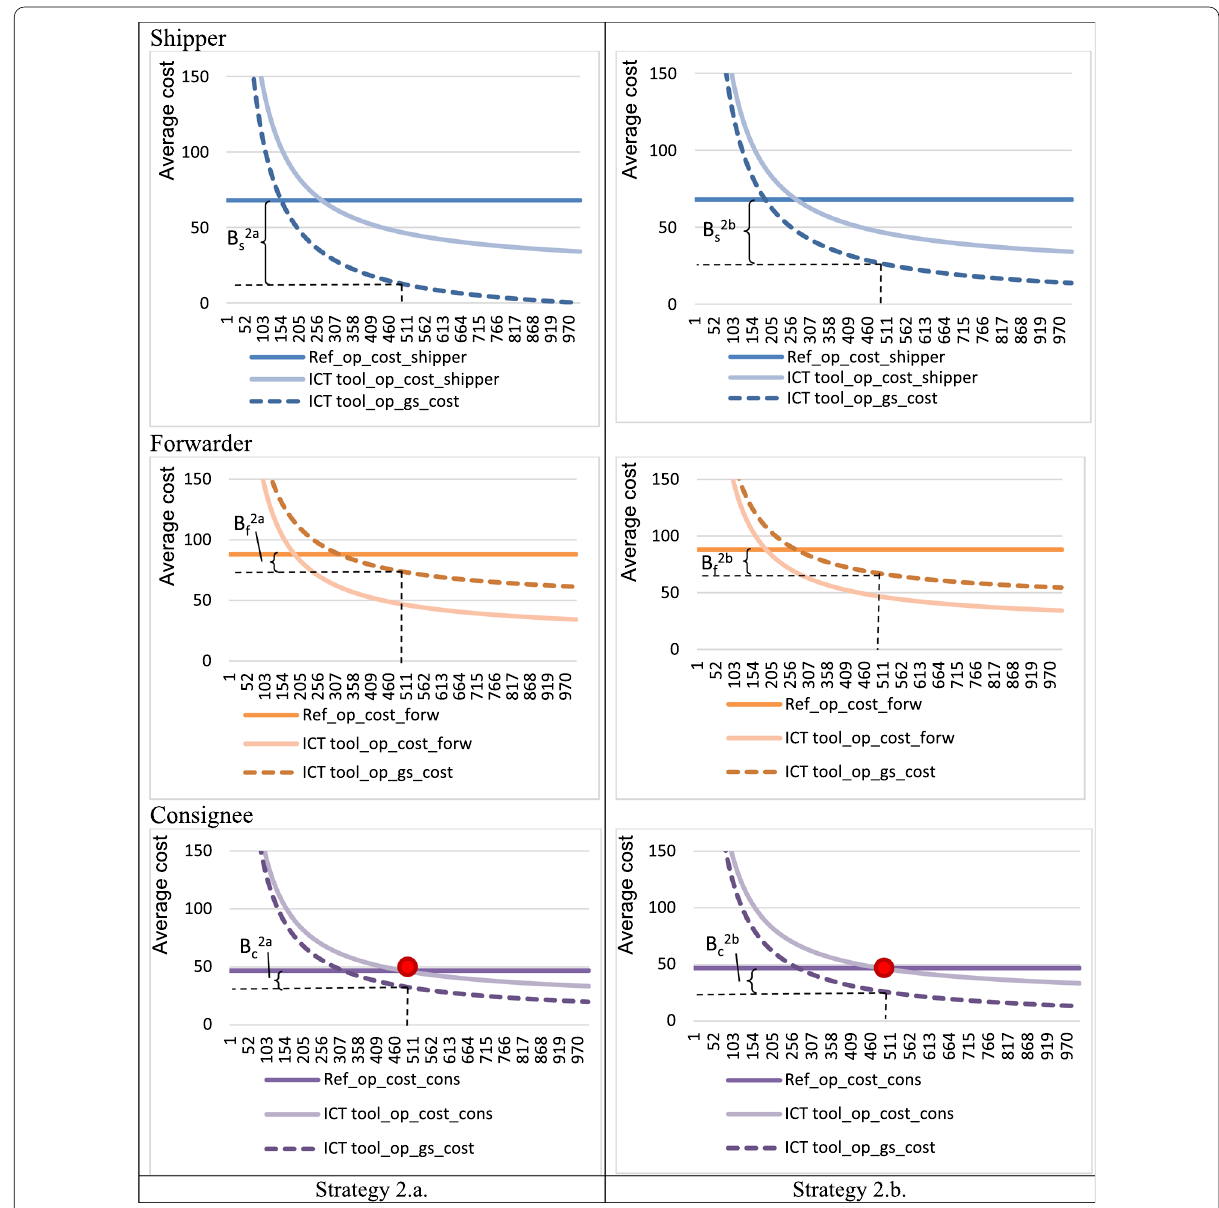
Fig. 6 User average costs if strategy 2 is applied. Source : own